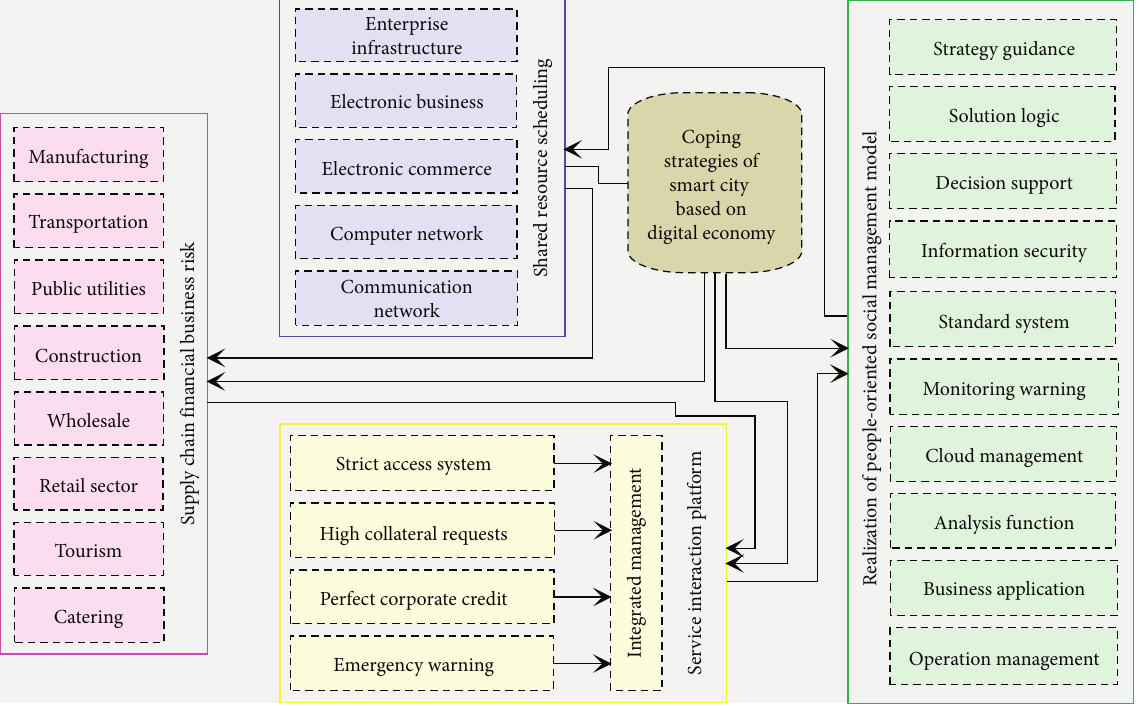
Figure 3: Integrated and people-oriented strategic management of smart city based on digital